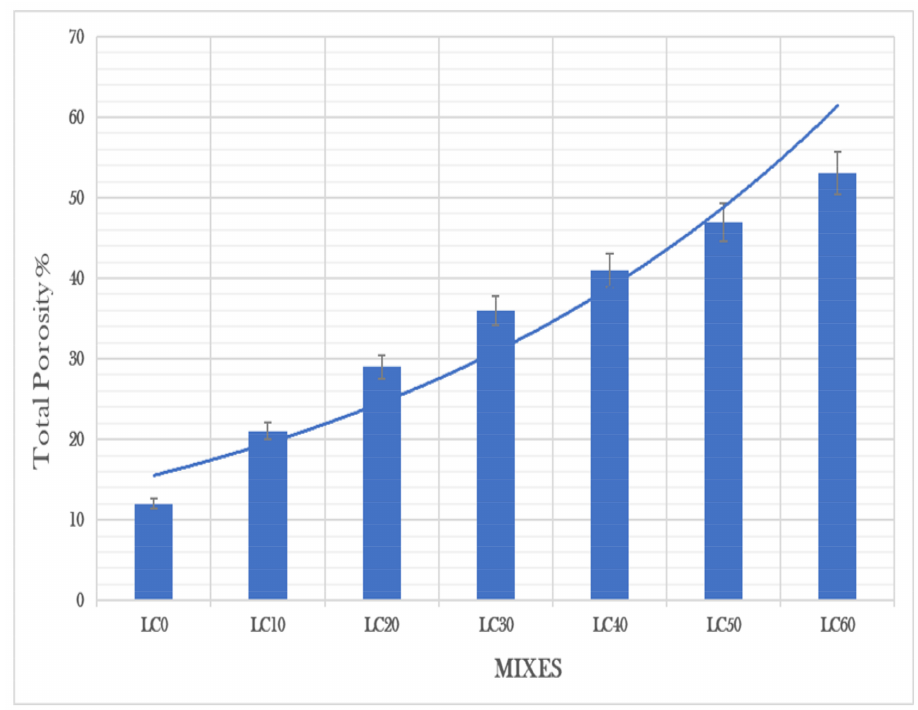
Figure 6. Effect of EPA aggregate dosage on total porosity of concrete